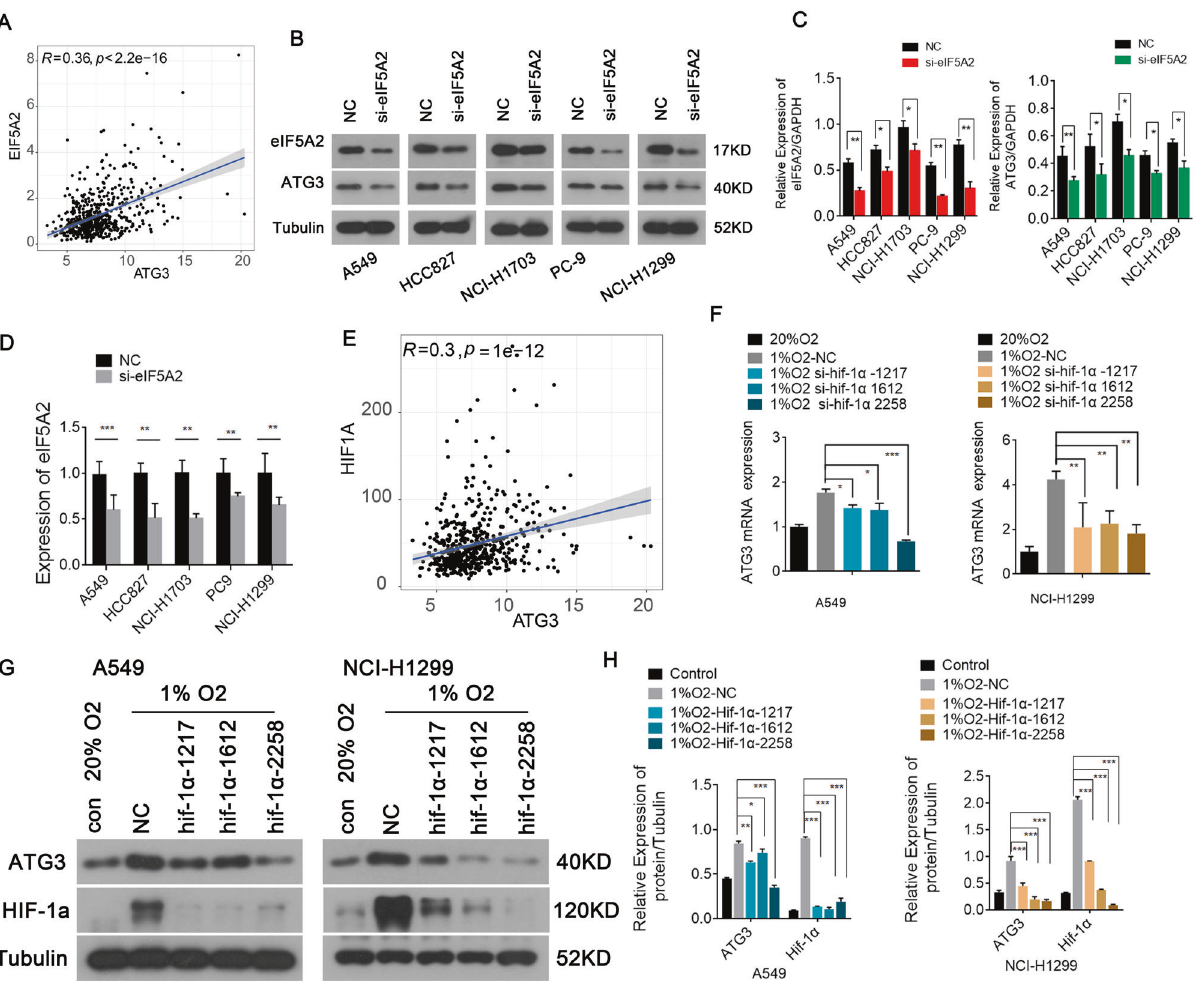
Fig. 5 ATG3 could be induced by eIF5A2 and HIF-1 α . A A scatter plot suggesting that eIF5A2 expression correlated signi fi cantly and positively with ATG3 expression (R = 0.36, p < 0.001). B , C Western blotting results demonstrating that ATG3 levels decreased with the knockout of eIF5A2. D qRT-PCR results exhibiting successful transfection. E A scatter plot revealing the signi fi cant and positive correlation between HIF-1 α and ATG3 expression (R = 0.29, p < 0.001). F – H qRT-PCR (F) and western blotting ( G , H ) indicating that ATG3 levels decreased after silencing HIF-1 α . * P < 0.05, ** P < 0.01, *** P < EIF5A2 downregulation enhances cisplatin ’ s ef fi cacy against NSCLC tumor growth The role of eIF5A2 in cisplatin resistance of NSCLC was further investigated through an in vivo subcutaneous model. The stripped NSCLC tissues are shown in Fig. 6A. We subcutaneously injected A549 cells into nude mice for NSCLC formation, and then injected them with reagents according to their group. Among the four treatment groups (saline, cisplatin only, eIF5A2 silencing only, and cisplatin plus eIF5A2 silencing), the tumors in the nude mice injected with NSCLC tissues with reduced eIF5A2 expression were non-signi fi cantly smaller than those in the mice injected with